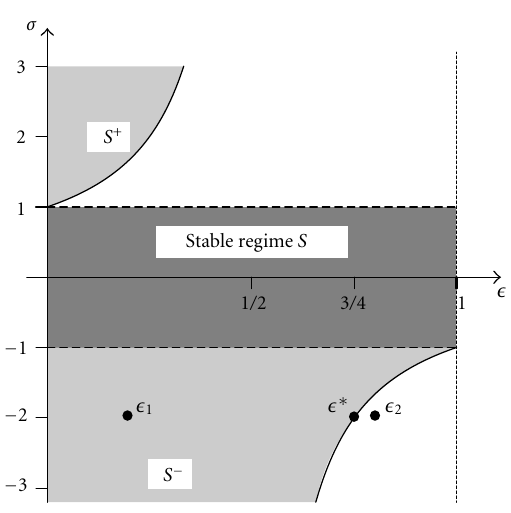
Figure 5.1. Stability regimes for x i , t +1 = G ((1 − (cid:1) ) x i , t + αx i +1, t + βx i − 1, t ), where (cid:1) = α + β